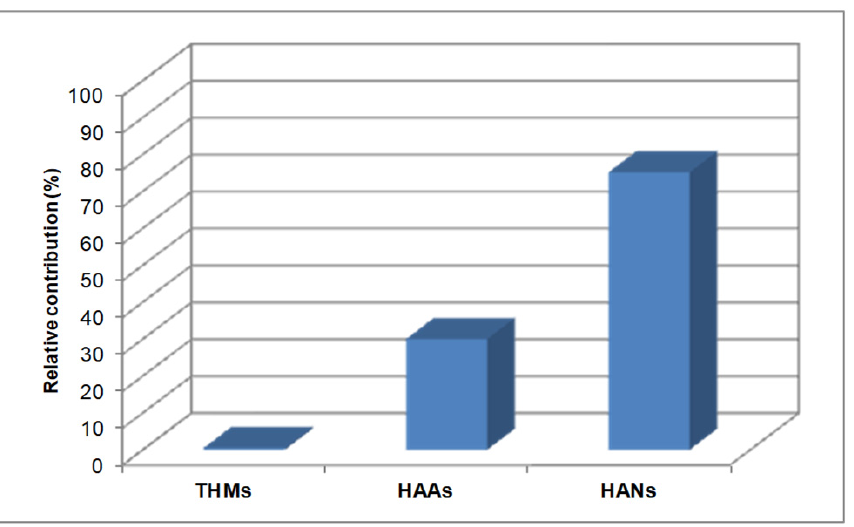
Figure 4. Relative contribution of DBPs groups to calculated overall cytotoxicity of water in swim- ming